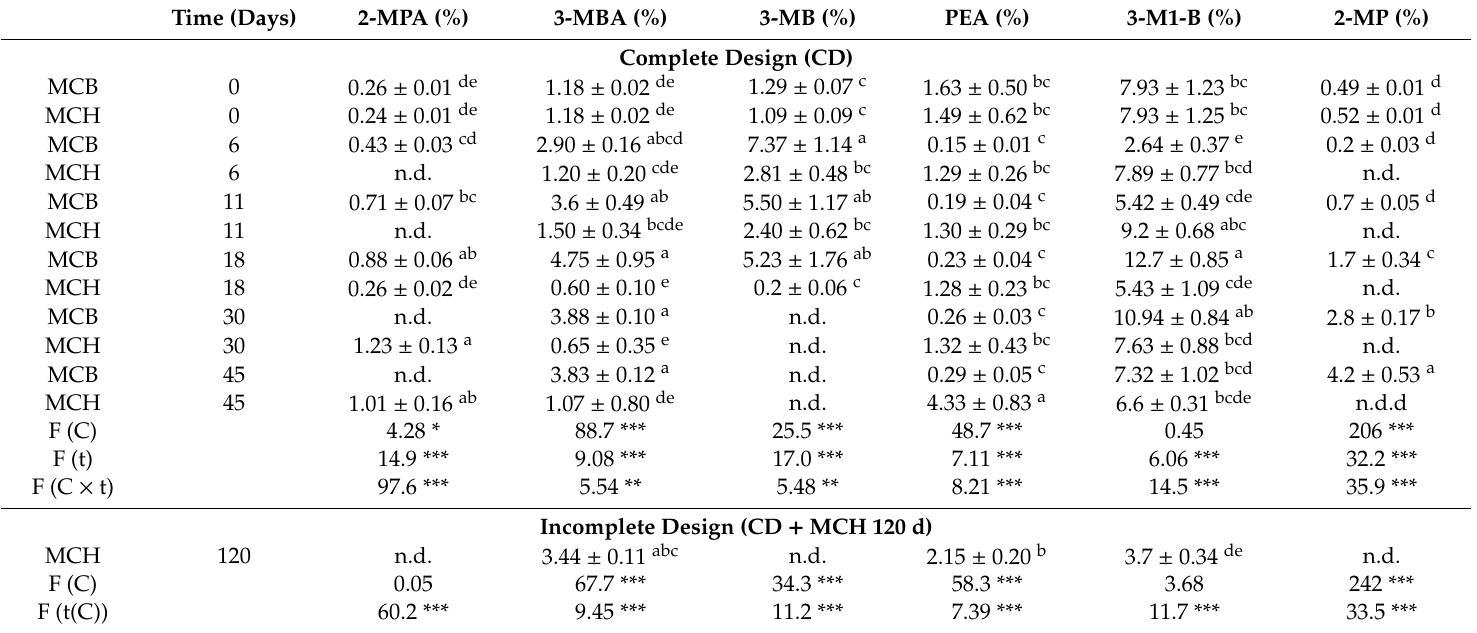
Table 3. Relative abundance of branched chain compounds derived from branched chain amino acids in “ Mortadella di Campotosto ”-like sausages produced with beef (MCB) and hog (MCH) casings over time. Results are expressed as relative abundance × 10 6